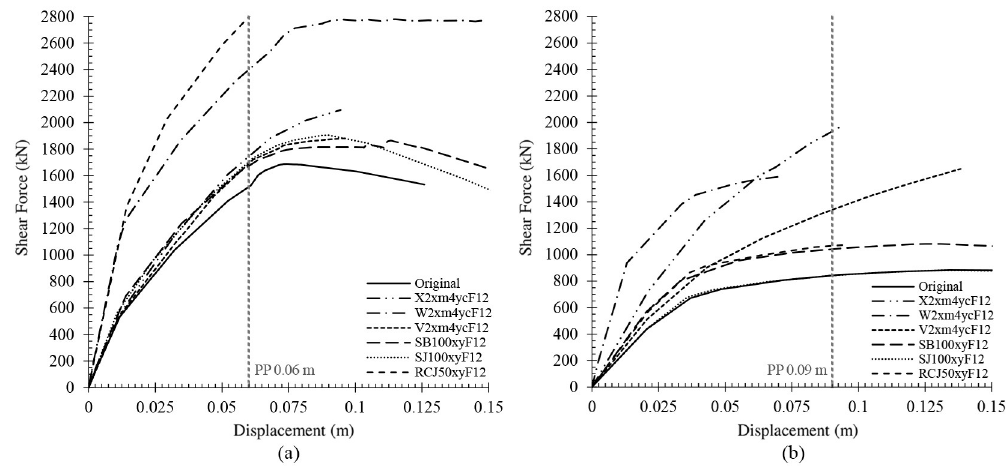
Fig 6. Capacity curves of the most effective solutions of each retrofitting technique in the X (a) and Y (b) directions.